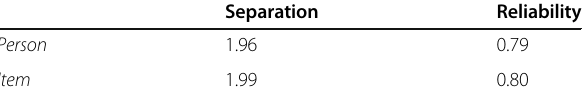
Table 3 Reliability and Separation of ITACS Items Separation